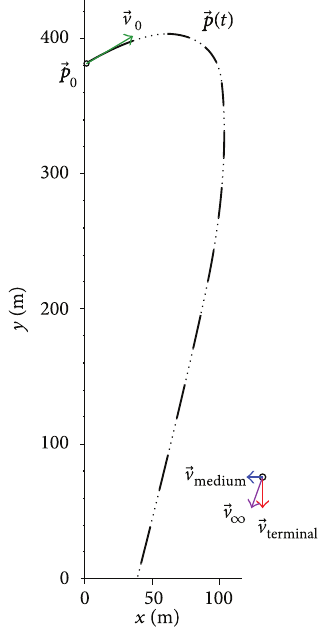
Figure 1: Serving a tennis ball from the Empire State Building